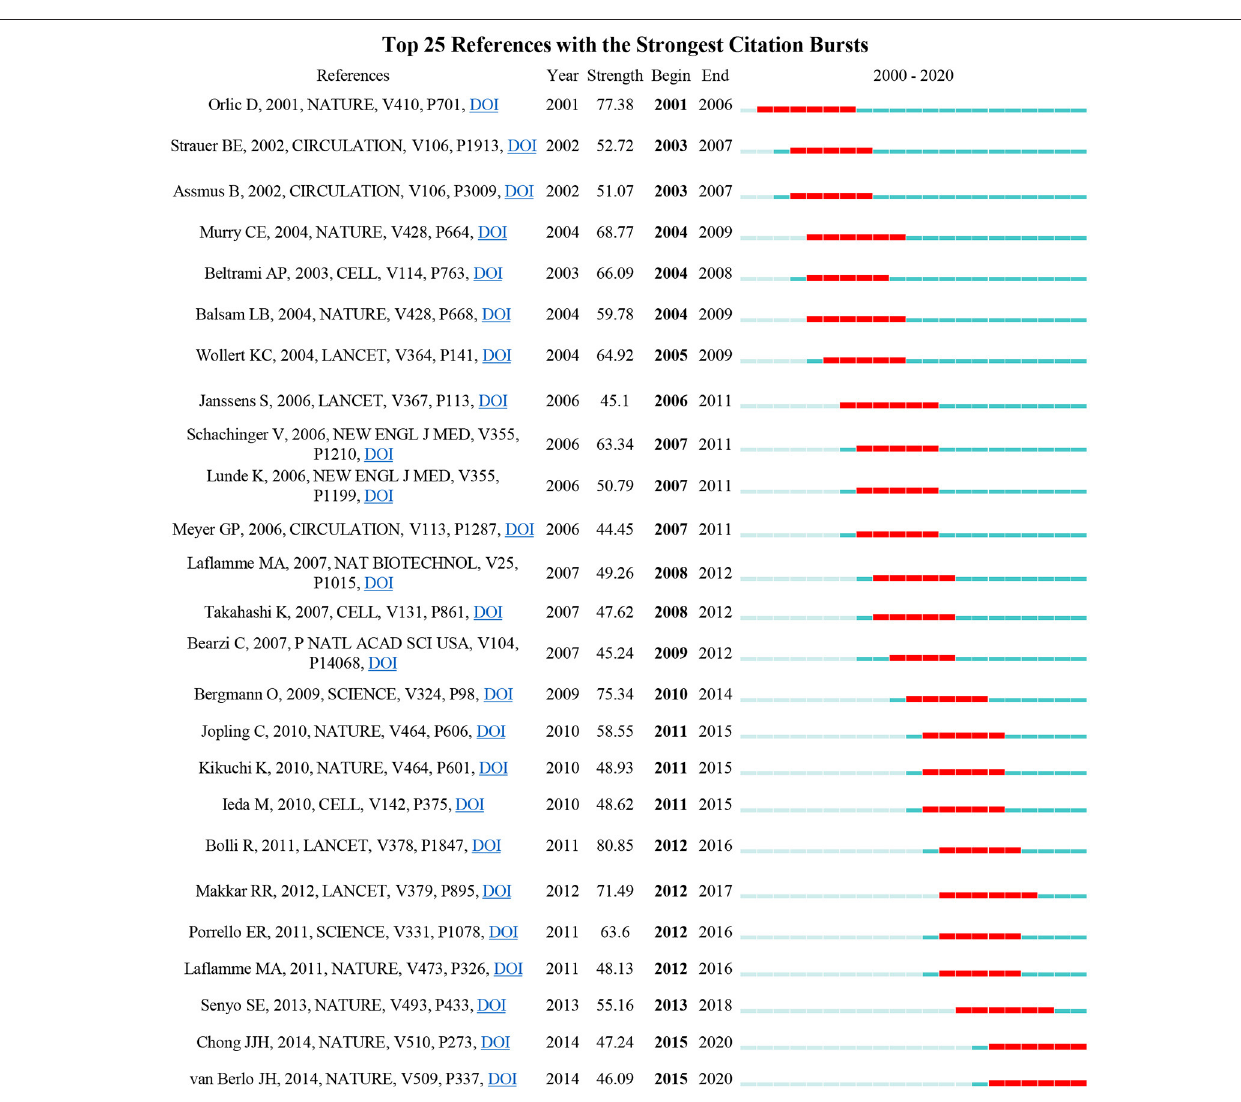
FIGURE 4 | The top 25 references with the strongest citation bursts. Two articles, authored by Chong and van Berlo, began to burst after